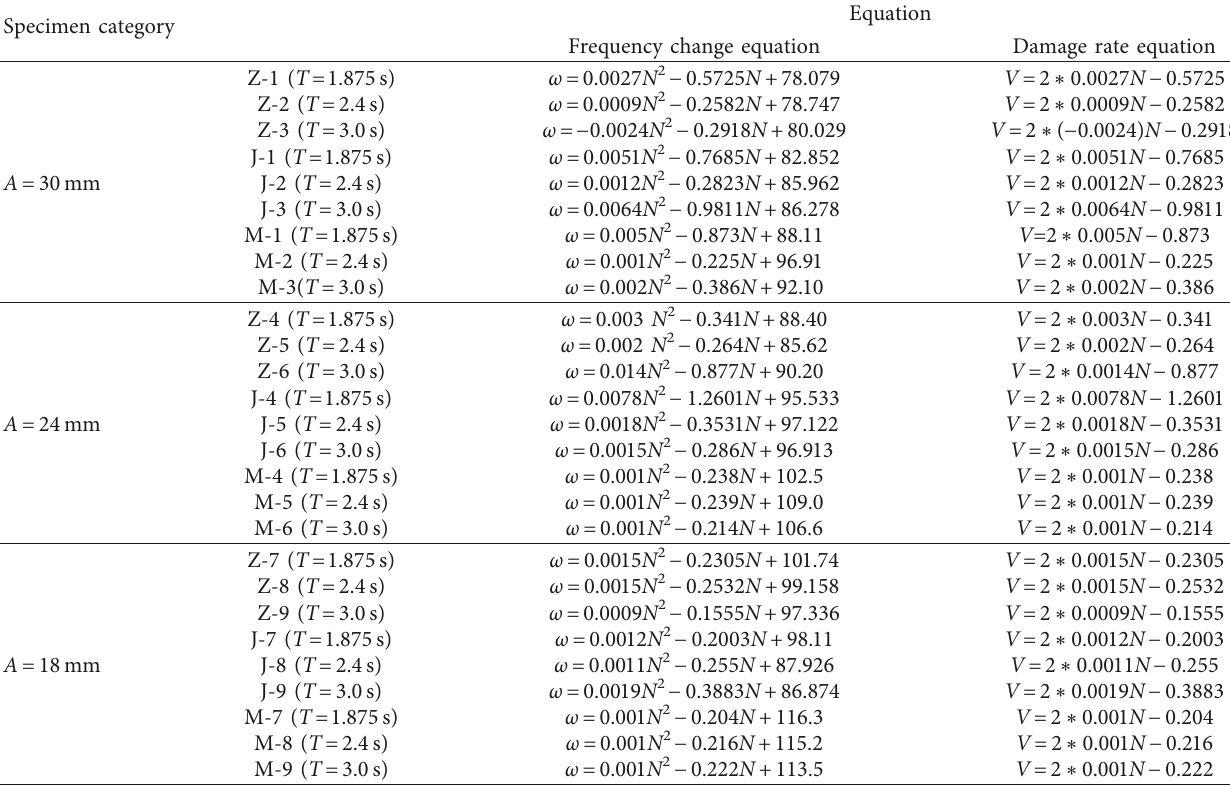
Table 5: Frequency change equations and damage rate equations of test